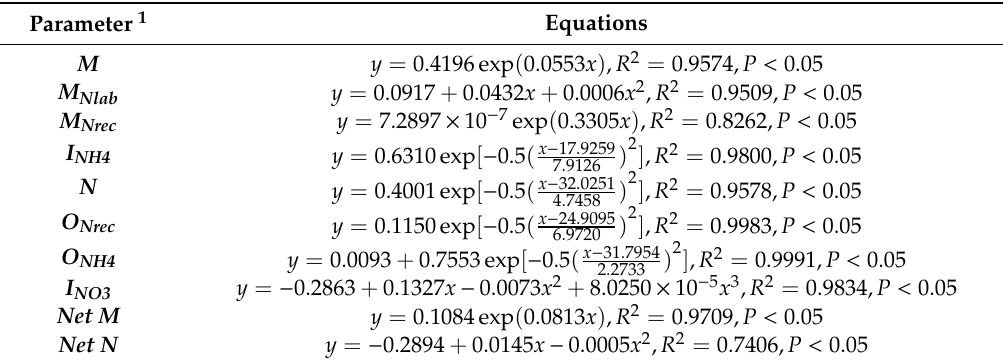
Table 1. Equations of fitted curves of gross rates of soil N transformation processes as a function of incubation temperature shown in Figure 3.